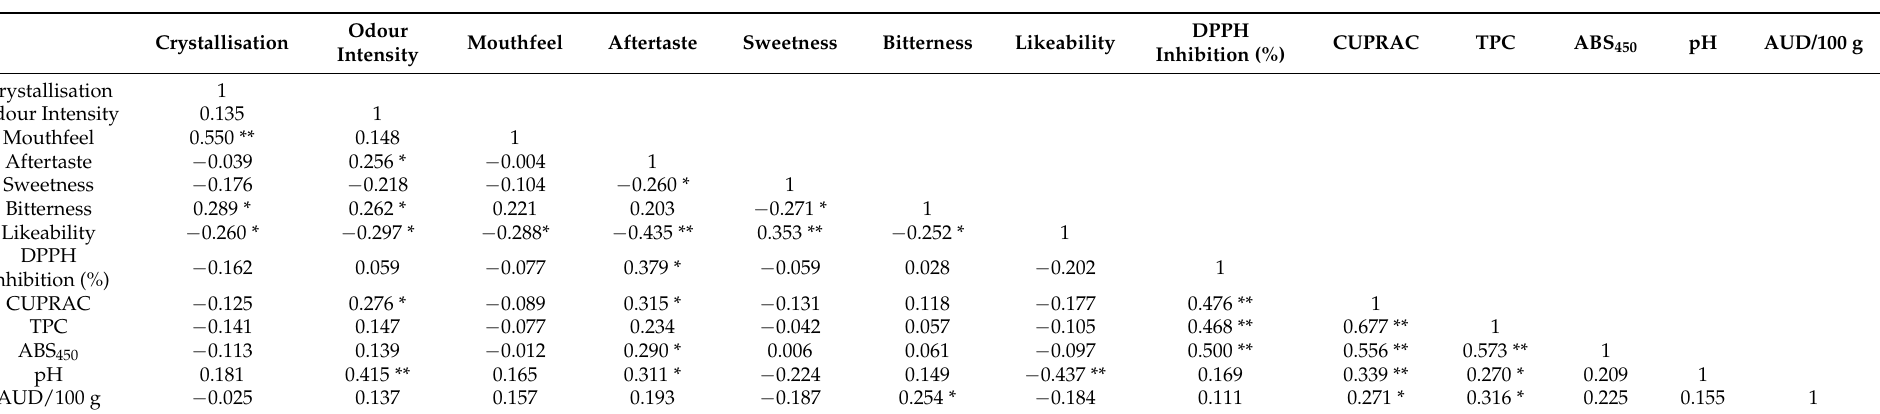
Table 2. Kendall’s Tau correlations between a selection of the sensory attributes, antioxidant characteristics, physicochemical properties, and the price of a range of commercially available Australian honeys. Odour Mouthfeel Aftertaste Sweetness Bitterness Likeability Crystallisation Intensity